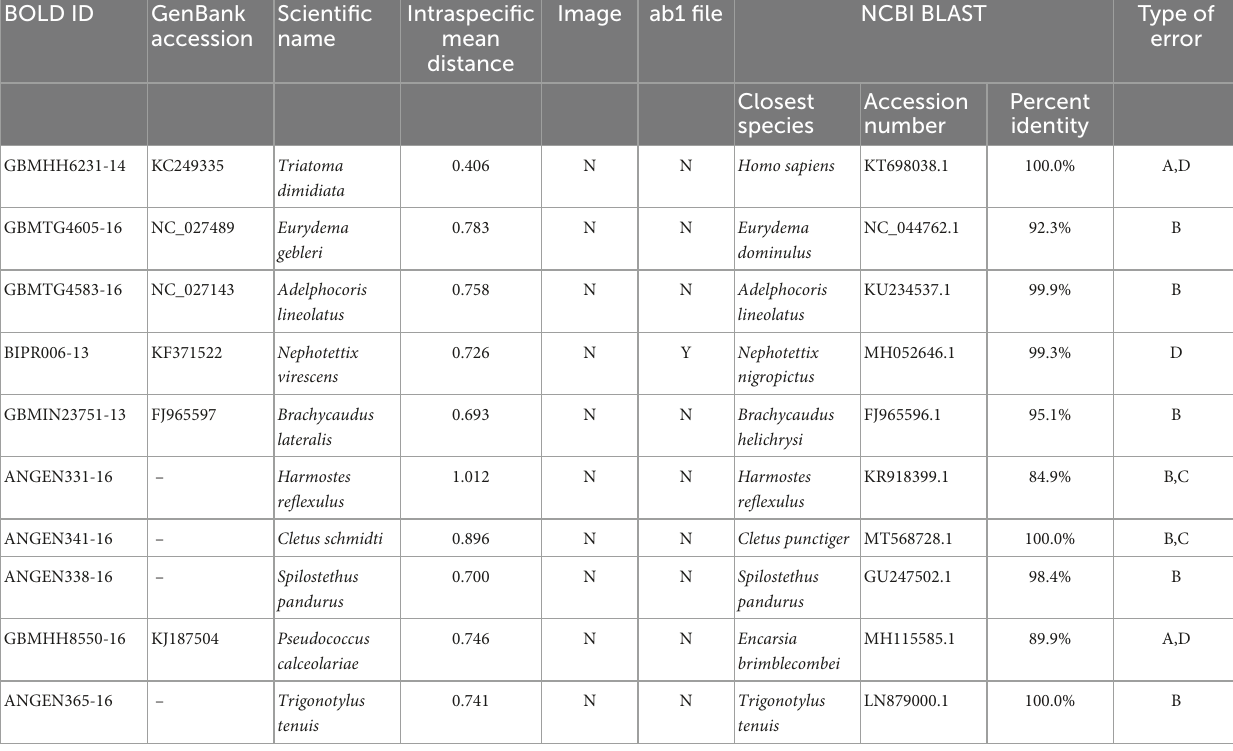
TABLE 1 BLAST results of ten sequences with very large intraspecific genetic